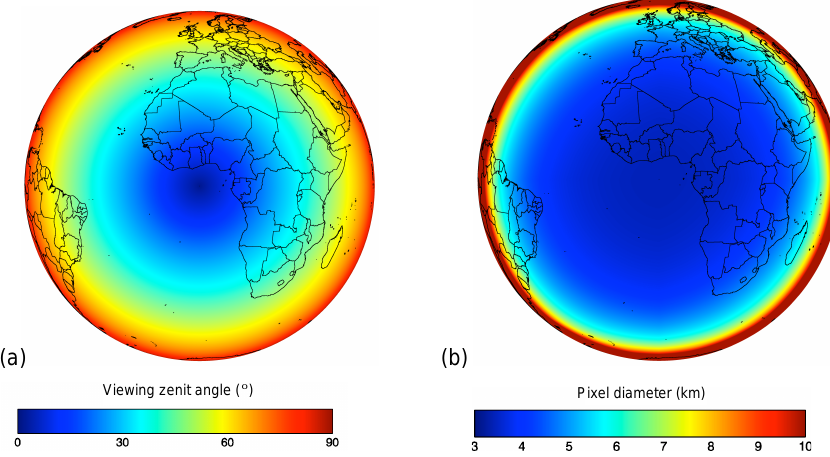
Figure 3. Area visible from SEVIRI at (0 ◦ N, 0 ◦ E): (a) view zenith angles, and (b) pixel spatial